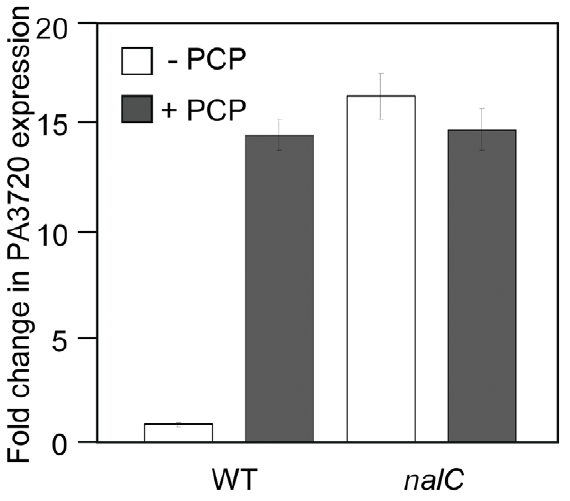
Figure 1. PCP induction of PA3720- armR . qRT-PCR results showing impact of PCP and/or a nalC mutation on PA3720 expression (as a measure of PA3720- armR expression). Expression of PA3720 is reported relative to the rpsL internal control for wild type P. aeruginosa K767 and its nalC derivative, K1454 exposed or not to PCP (0.75 mM; 1.5 hr). Results shown are the mean + / 2 standard error of one cDNA sample for each, processed in triplicate, and are representative of 2 independent experiments.